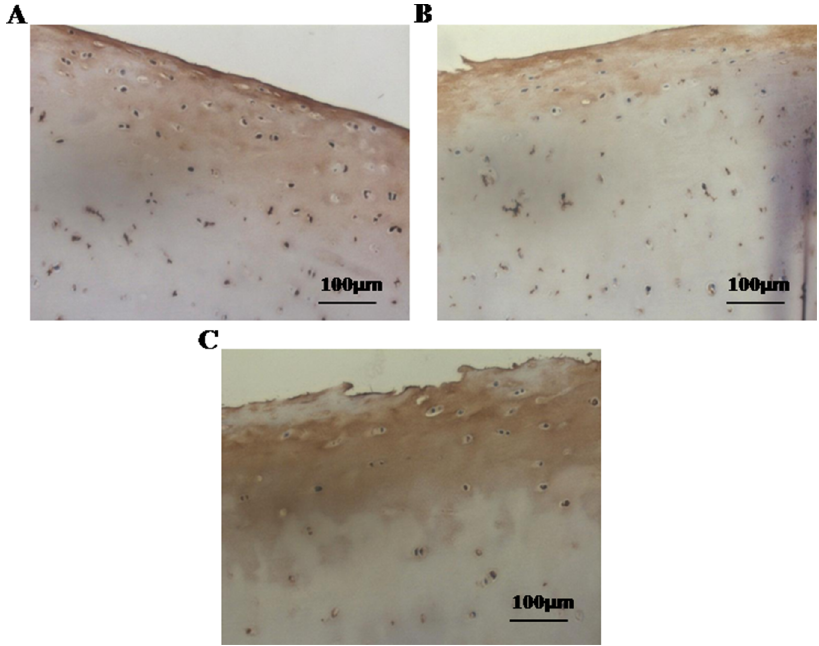
Figure 2. Expression of lubricin by human articular cartilage explants of different OA stages from total hip replacement operations. Immunostaining of lubricin represented decreased expression of lubricin in early (B), and advanced OA cartilage (C) than normal cartilage (A); Magnification x20; scale bars 100 m m.